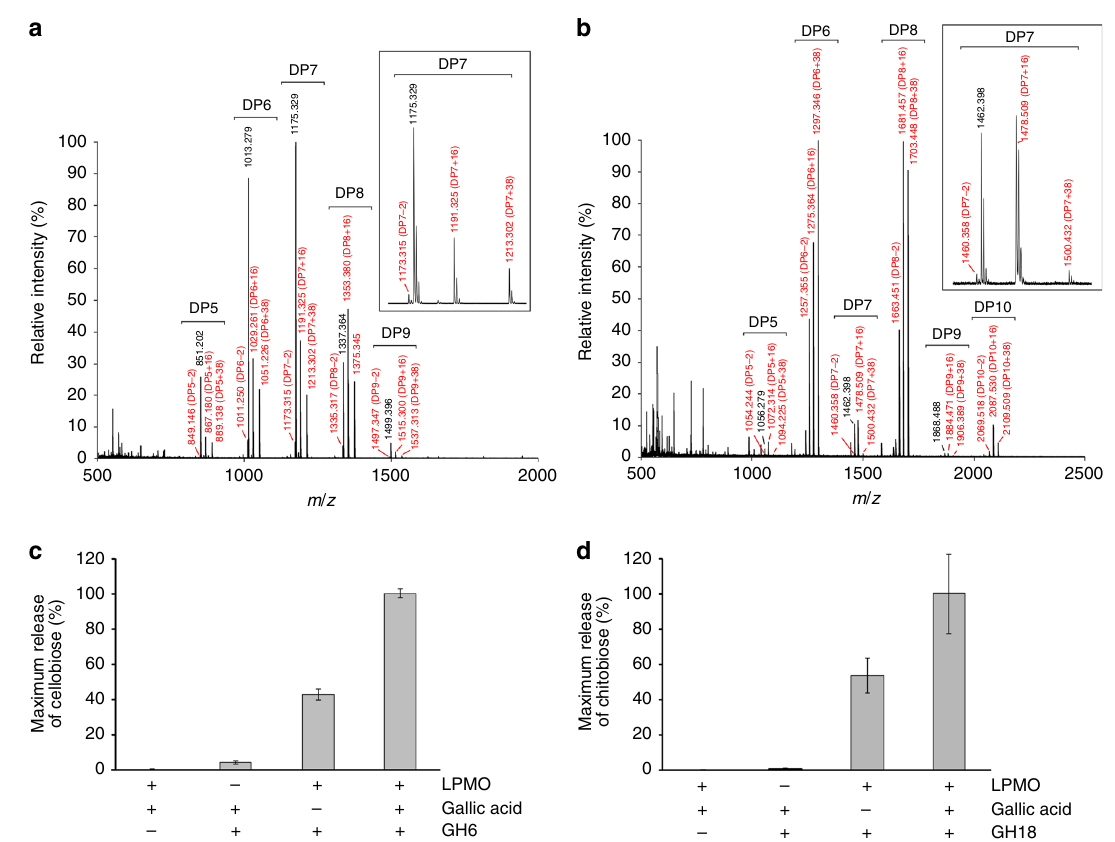
Fig. 3 Biochemical characterization of Td AA15A. MALDI-TOF MS spectrum of products obtained after incubation of 4 mg mL − 1 microcrystalline cellulose ( a ) or β -chitin ( b ) with 2 µ M Td AA15A and 4 mM gallic acid for 24 h, showing native and oxidized oligosaccharides. For both substrates, the main peaks correspond to mono- or di-sodiated adducts of C1-aldonic acids, imparting + 16 or + 38 m/z respectively, relative to the mono-sodiated unoxidized